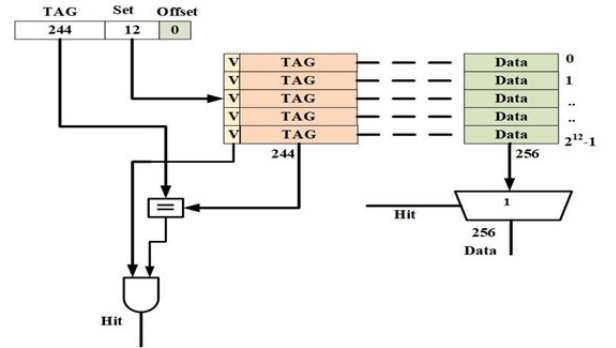
Figure 7. Direct-mapping block diagram.